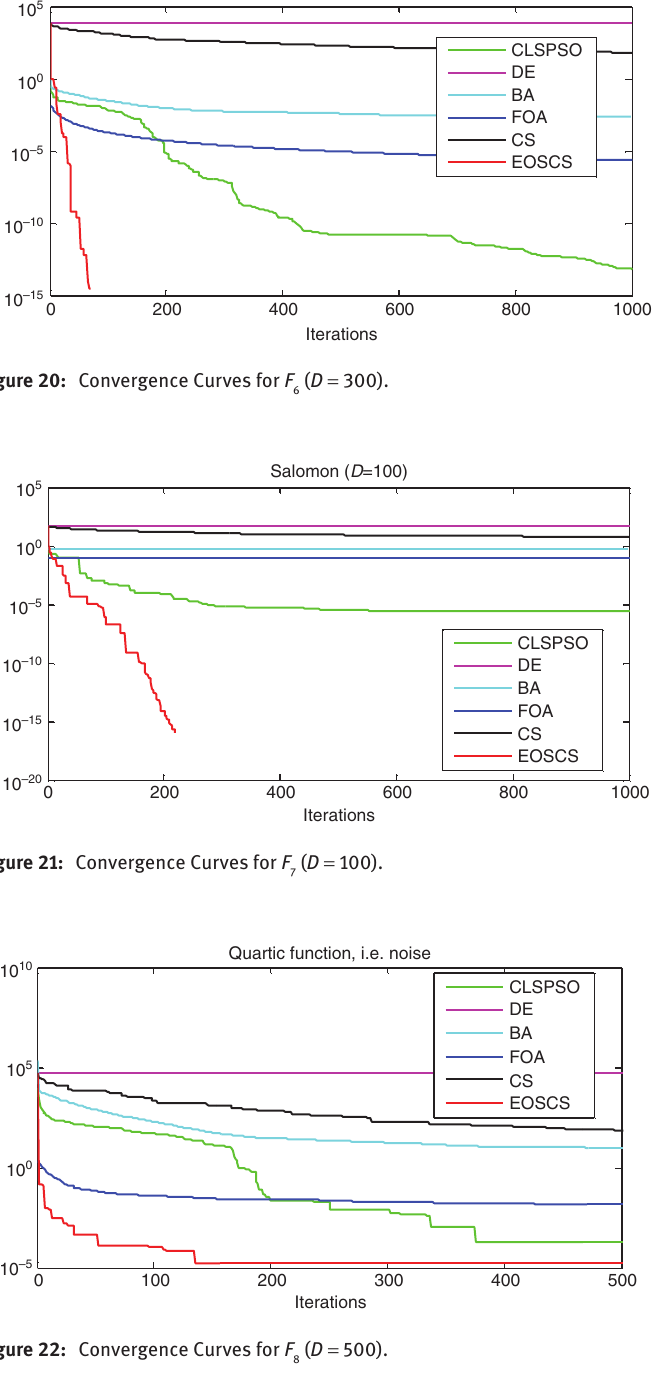
Figure 22: Convergence Curves for F